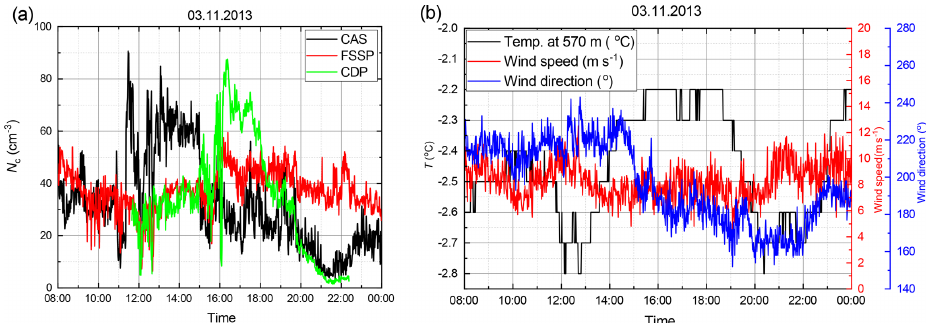
Figure 3. Time series of 1min averages on 3 Nov 2013; (a) N c of each cloud probe along with (b) temperature, wind speed and wind direction are presented. This is a typical example of the cloud probes accumulating ice. From 12:00 we can see a drop in N c of the CAS. The sudden increase just before was a clear sign of probe inlet freezing. The same behavior could be also seen for the CDP after 16:00. When ice was accumulated, the opening of the probe inlet became smaller, which resulted in a raised PAS. While deriving N c to evaluate our data set, we considered the PAS to be constant. The underestimation of the PAS explains the abnormality in N c